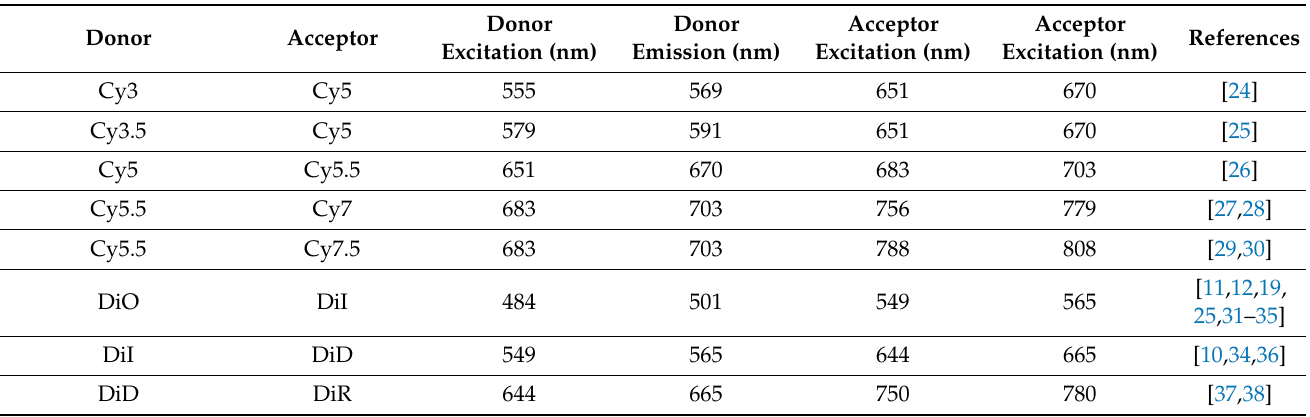
Table 1. Common FRET